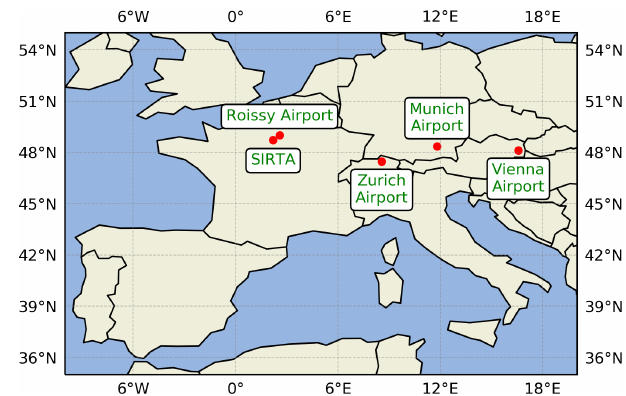
Figure 1. Map of the different instrumental sites used in this